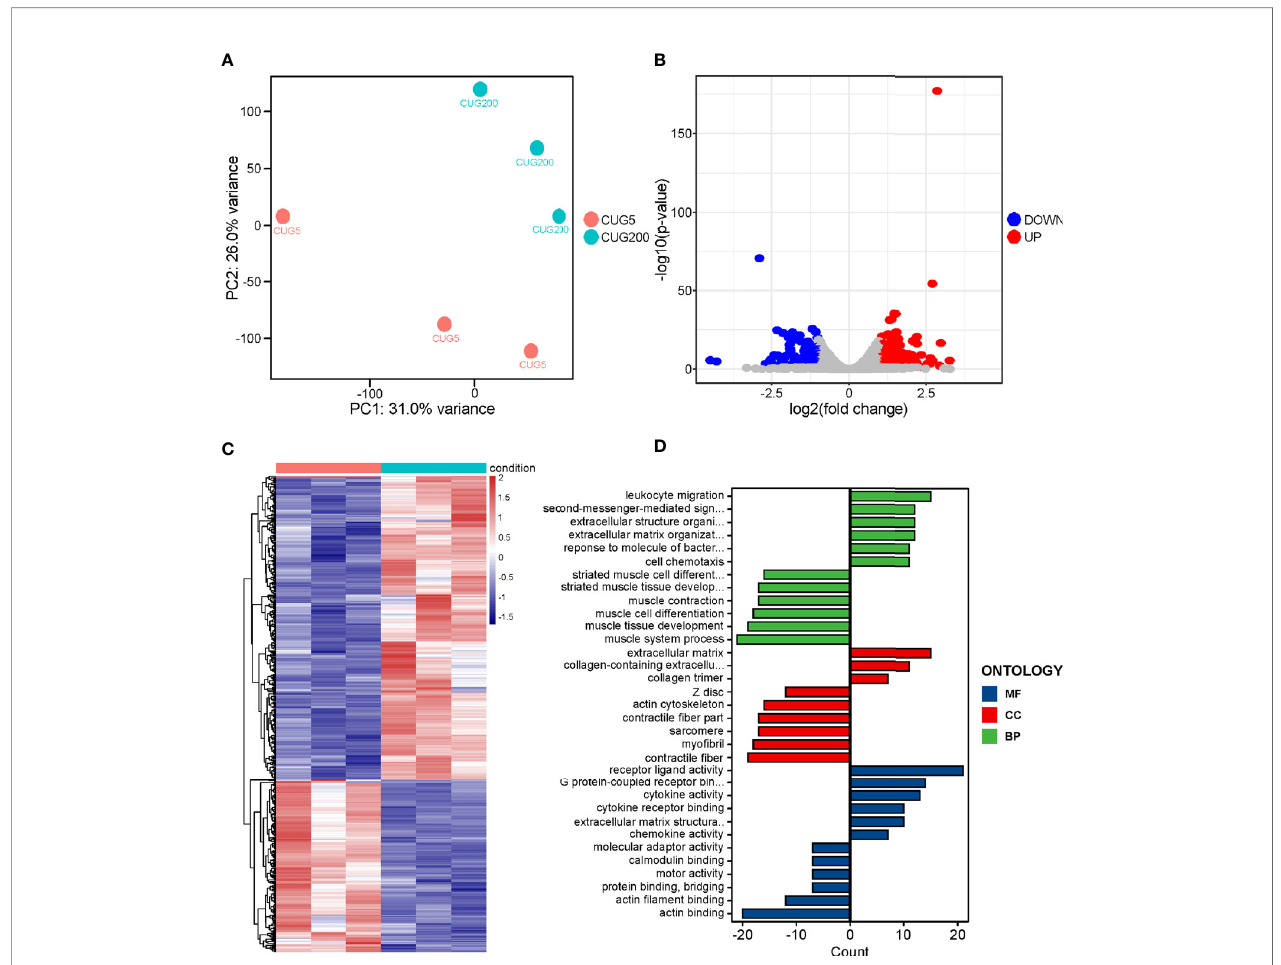
FIGURE 2 | RNA-seq on the differentiating normal and DM1 myoblasts. (A) PCA of the RNA-seq data. There were three replicates for each group. (B) The volcano plot displayed the distribution of DEGs. Red dots represented the signi fi cantly upregulated genes and blue dots represent signi fi cantly downregulated genes. |log 2 (Fold Change)| > 1 and adjusted P-value < 0.05 were used as the cut-off value. (C) Heatmap showed the relative levels of DEGs between the normal and DM1 groups. (D) The GO analysis of DEGs. CUG5, the normal group; CUG200, the DM1 group; MF, molecular function; CC, cellular component; and BP, biological process;